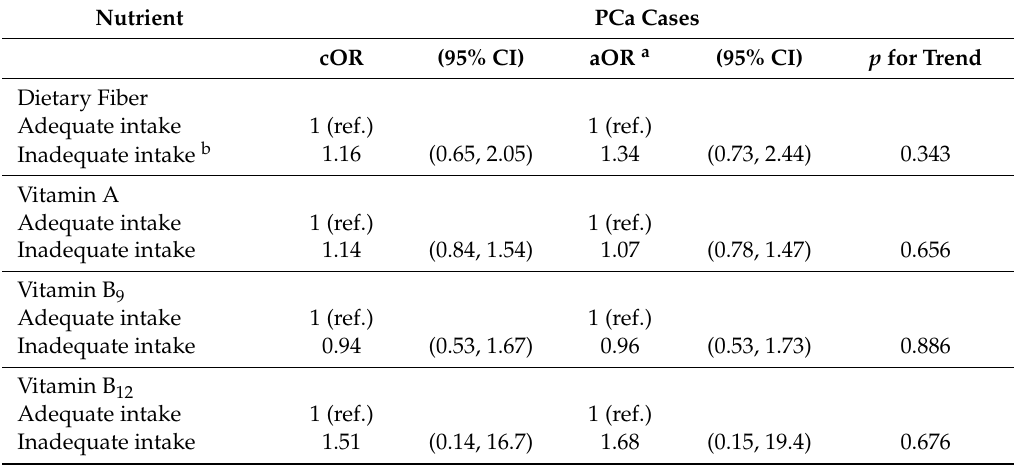
Table 6. Logistic regression model for the risk of PCa and the micronutrient intakes of the dietary intake according to the recommendations proposed by the European Food Safety